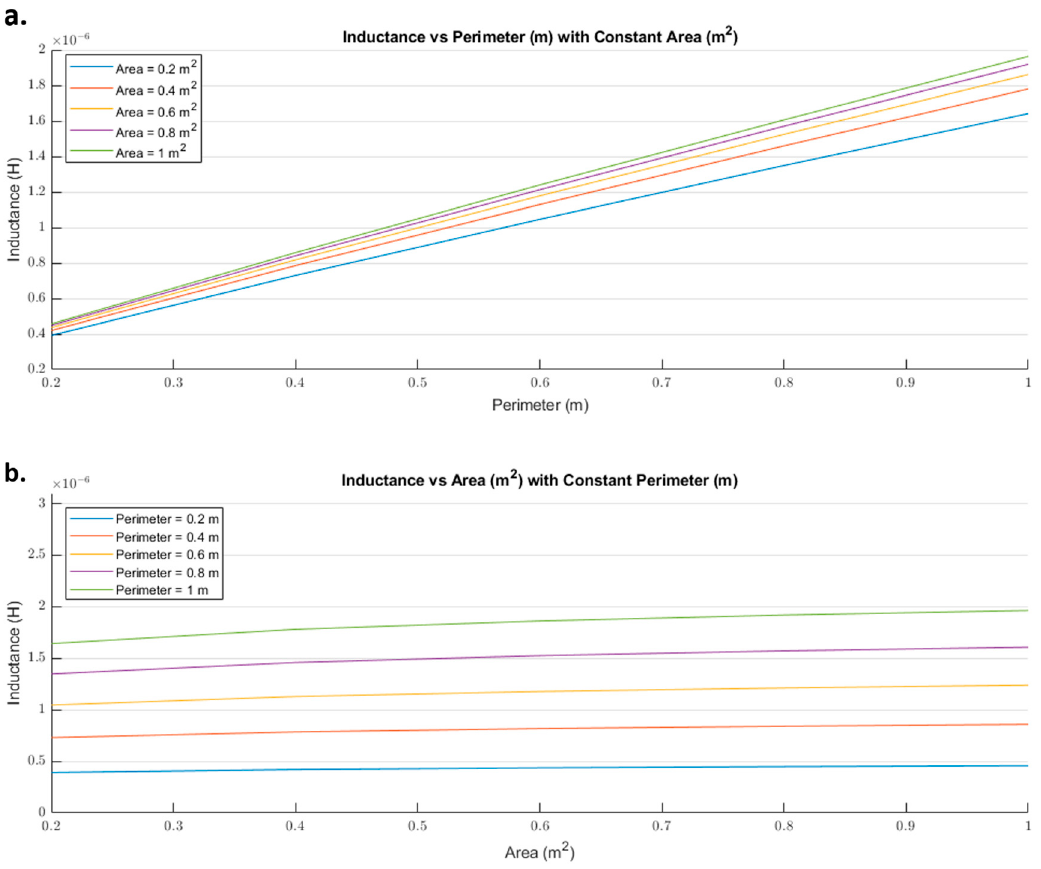
Figure 2. Inductance (H) behavior based on the area (m 2 ) and perimeter (m) of a polygon using a round wire: ( a ) Inductance value vs. perimeter with a constant area; ( b ) inductance vs. area with a constant perimeter.